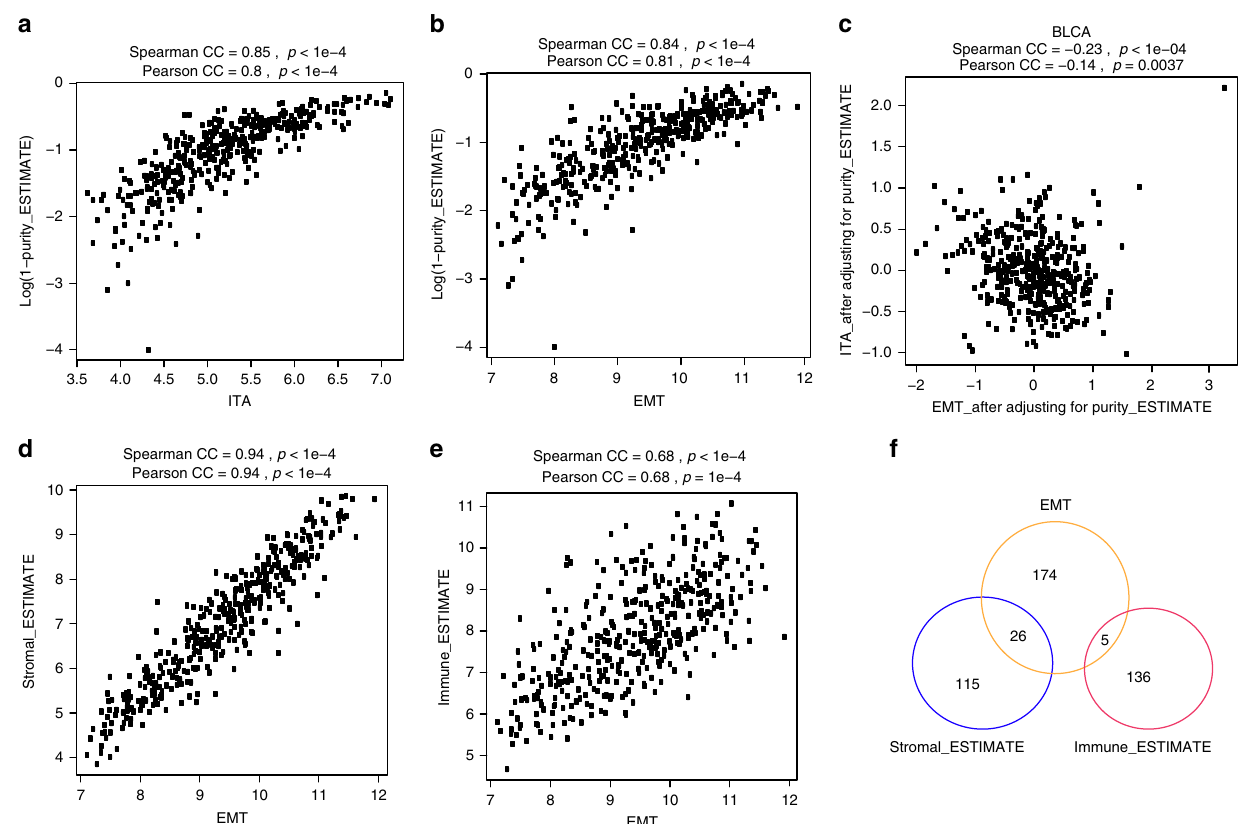
Fig. 3 EMT-related gene expression is inversely correlated with tumor purity in UC specimens and likely emanates from stroma. Plot of correlation between a tumor purity and ITA, b tumor purity and EMT-related genes, c tumor purity adjusted ITA and EMT, d EMT-related genes and stromal signature (average of stromal_ESTIMATE gene expression), and e EMT-related genes and average of immune_ESTIMATE gene expression in TCGA UC samples; f Overlap among EMT-related, stromal_ESTIMATE and immune_ESTIMATE gene sets